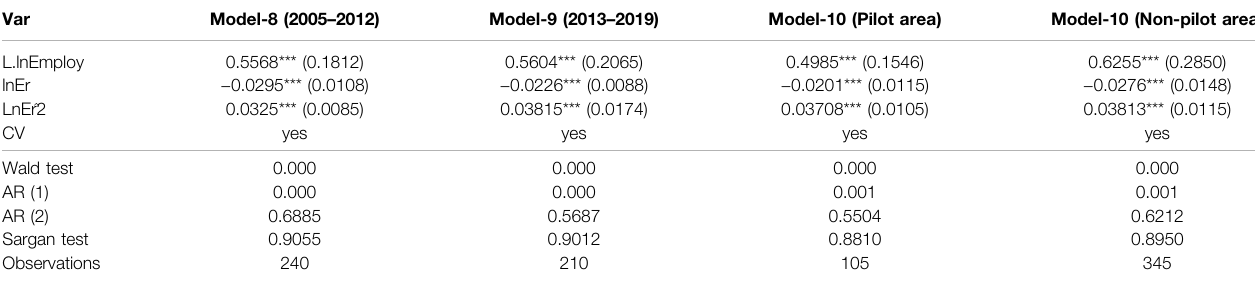
TABLE 5 | Robustness test of employment effect of carbon emission regulation (Explained variable: lnEmploy; SYS-GMM).